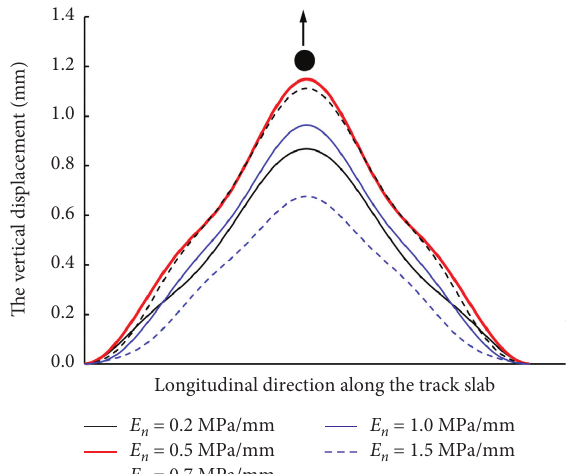
Figure 27: Maximum rebound deformation of the selected side for various E